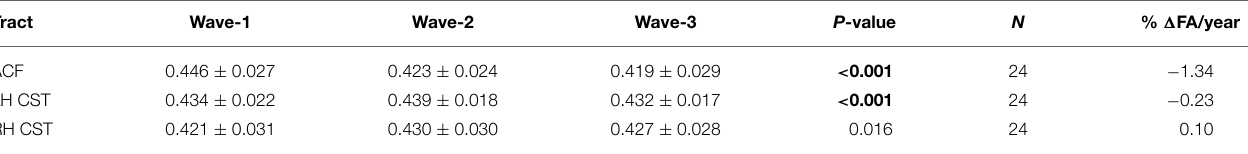
TABLE 7 | Mean and standard deviation of tract mean FA in the in the anterior callosal fiber (ACF) bundle, and in left and right hemispheres (LH, RH) of the corticospinal tract (CST) that were detected in the subsample of 24 participants having three MRI examinations: at baseline (column 2), at first follow-up (column 3), and at second follow-up (column